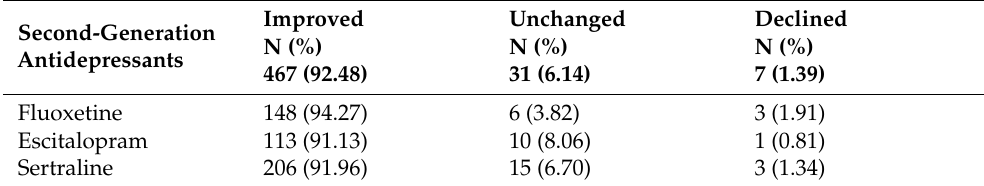
Table 2. Percentage of individuals showing a change in K6 scores based on Fluoxetine, Escitalopram, Sertraline.